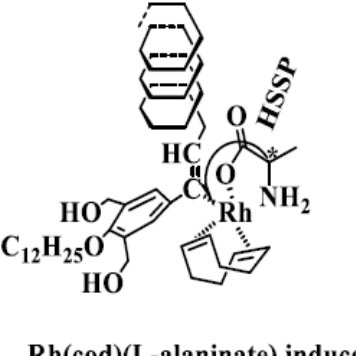
Chart 1. Mechanism of helix-sense-selective polymerization ( HSSP) of DoDHPA by the [Rh( L -alaninate)(cod)] catalyst.